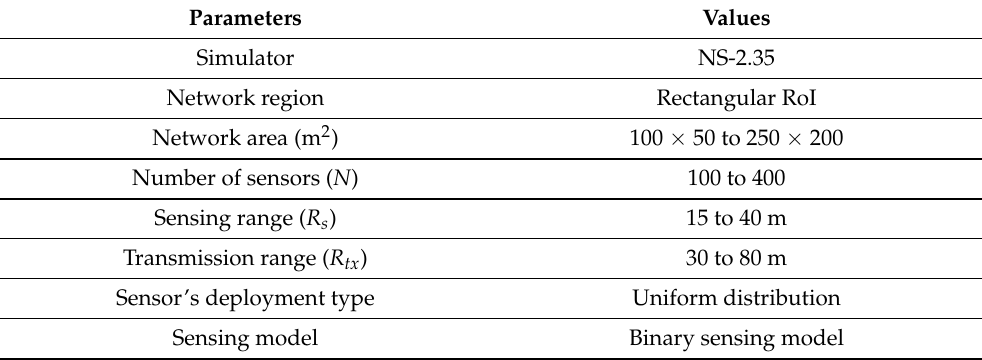
Table 1. Simulation